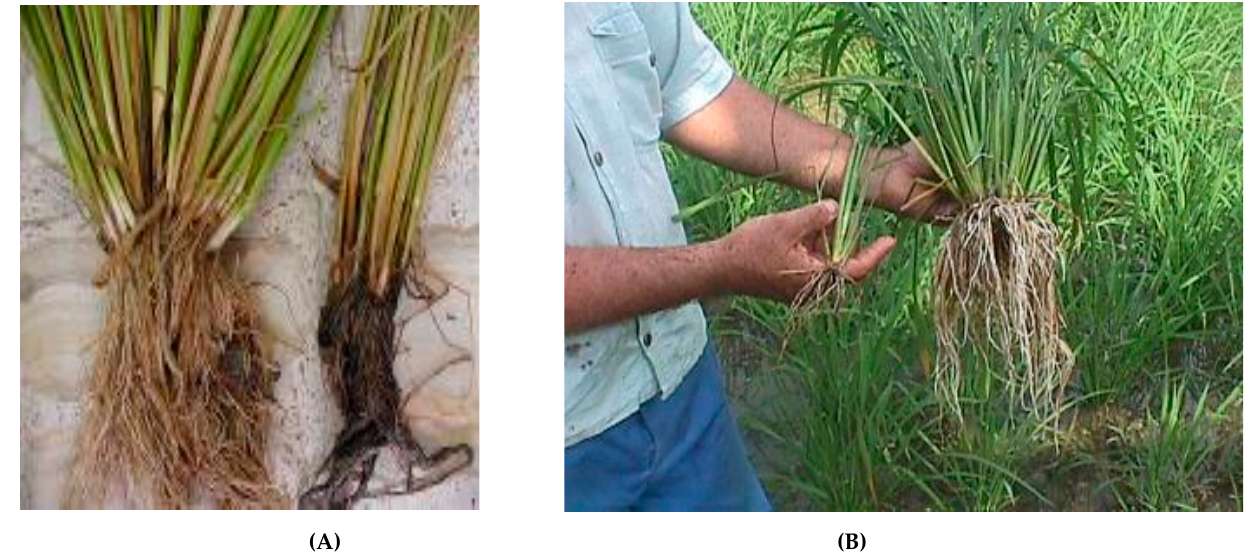
Figure 4. A. The pair of rice plants grown, respectively, using SRI vs. standard methods of rice cultivation at the Haraz Extension and Technology Development Center in Amol, Iran. The dark color and stunting of the right-hand plant’s roots reflect their degeneration due to lack of oxygen. B. The pair of rice plants grown in Cuba are of the same age (52 days) and the same variety (VN 2084). Right-side plants are grown using SRI and have 43 tillers, and the left one grown using the standard method have only 5 tillers.